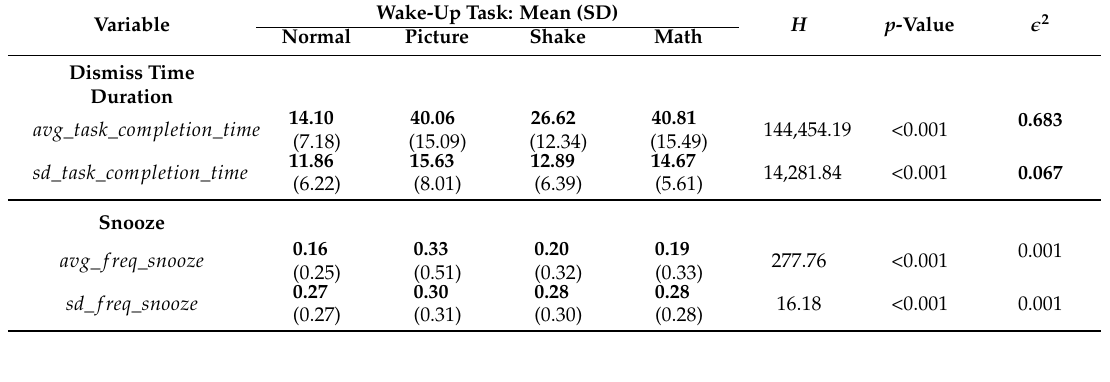
Table 3. Alarm dismiss-usage comparison among the wake-up tasks (Kruskal–Wallis H test).